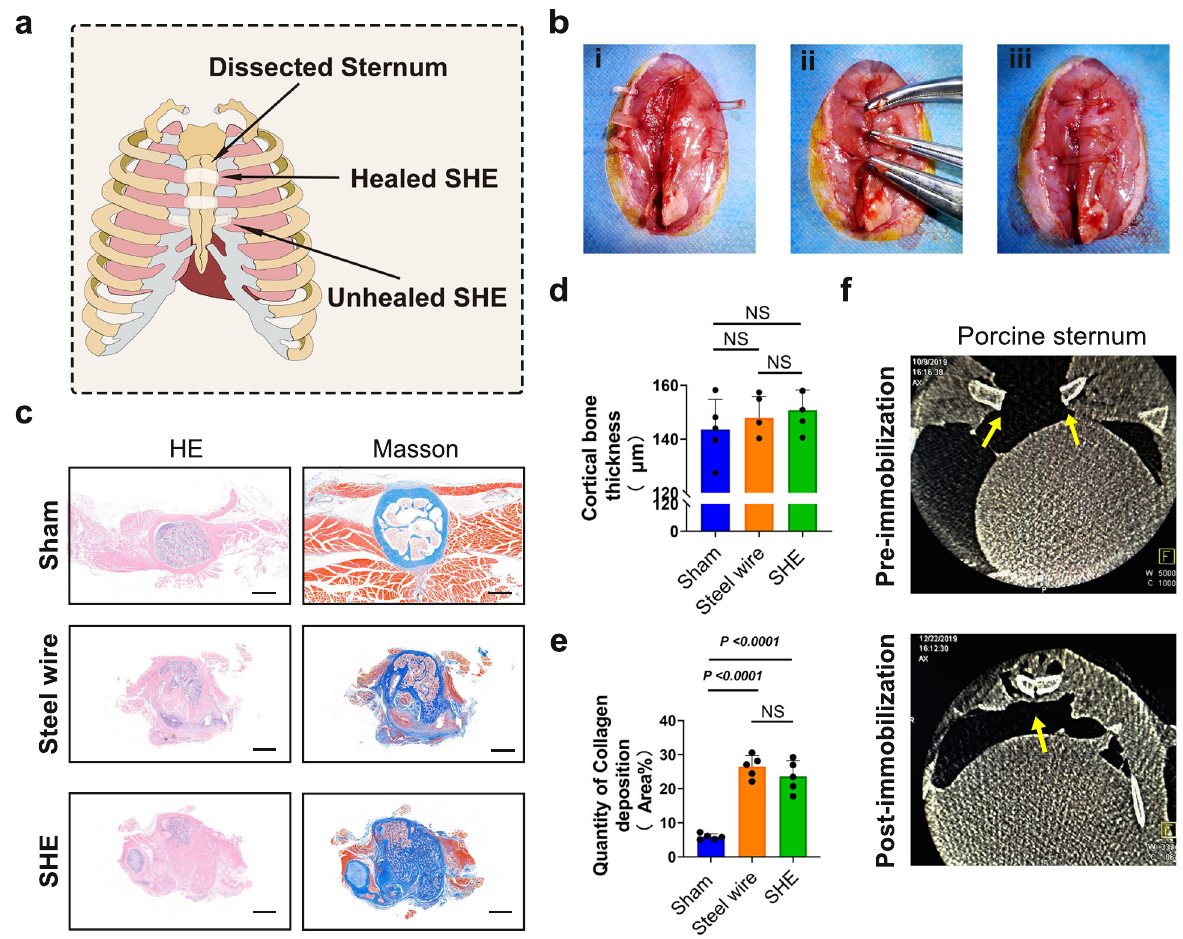
Fig. 5 Pattern diagram of sternum immobilisation by elastomer, surgical procedure of immobilisation, HE and Masson trichrome staining of sternum, spinal X-ray imagination of porcine sternum. a Pattern diagram of sternum immobilisation by elastomer. b Surgical procedure of sternum immobilisation by elastomer in rat. c HE staining of rat sternum in sham, control and elastomer group. Masson staining of rat sternum in sham, steel wire and SHE group (blue part represented the deposition of collagen in sternum bone), scale bar = 500 μ m. d Statistical scatter diagram of cortical bone thickness of rat sternum in sham, control, elastomer group ( n = 5 in each group). e Statistical scatter diagram of collagen deposition of rat sternum in sham, control, elastomer group ( n = 5 in each group). f Spinal X-ray imagination of porcine sternum (cross section) before and after immobilisation, respectively. High density shadows of sternum were marked with yellow arrows. Data were presented as mean ± s.d. Ordinary one-way ANOVA test with Tukey ’ s multiple comparisons test ( d , e ) was used for analysis of cortical bone thickness and quantity of collagen deposition. Cortical bone thickness ( d ): Sham compared to Steel wire, ns p = 0.7406; Sham compared to SHE, ns p = 0.4386; Steel wire compared to SHE, ns p = 0.8631; Quantity of collagen deposition ( e ): Sham compared to Steel wire, **** p < 0.0001; Sham compared to SHE, **** p < 0.0001; Steel wire compared to SHE, ns p = 0.3908. Source data are provided as a Source Data fi le. NS no signi fi